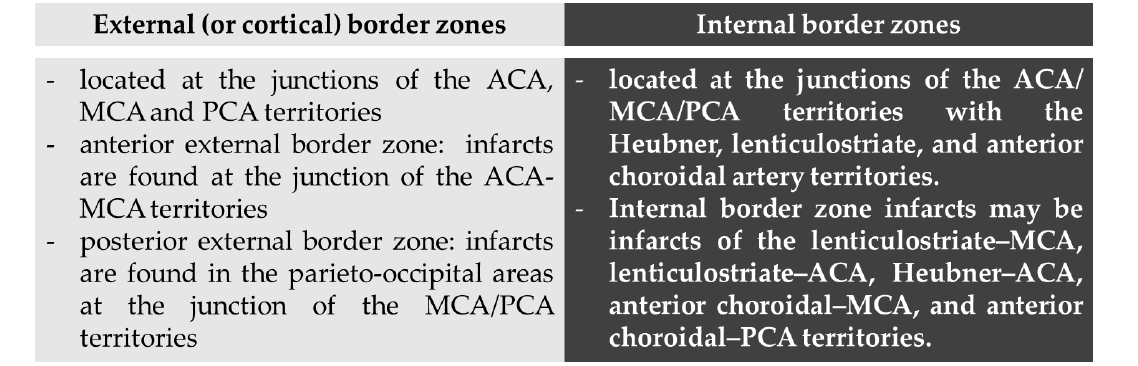
Figure 4. Types of border zones and corresponding infarcts according to their location.